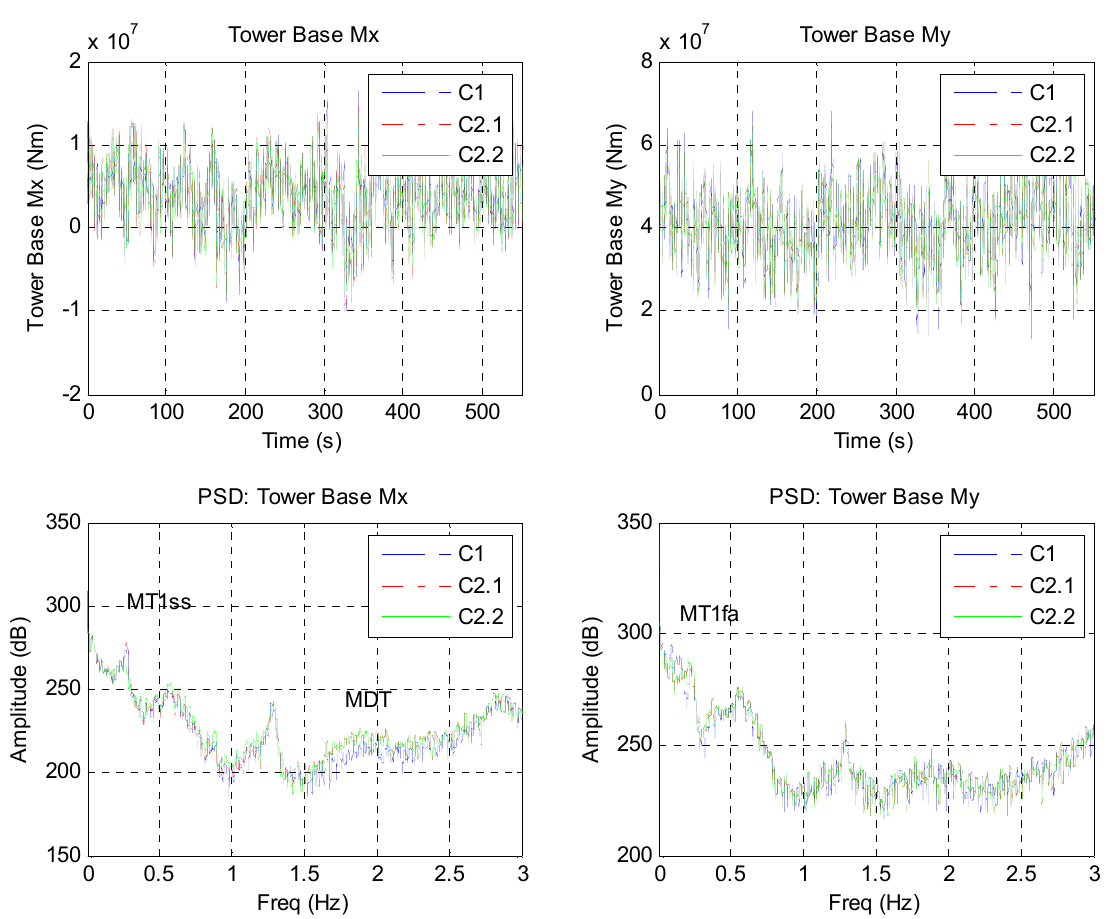
Figure 19. Loads on tower base with a turbulent production wind of 19